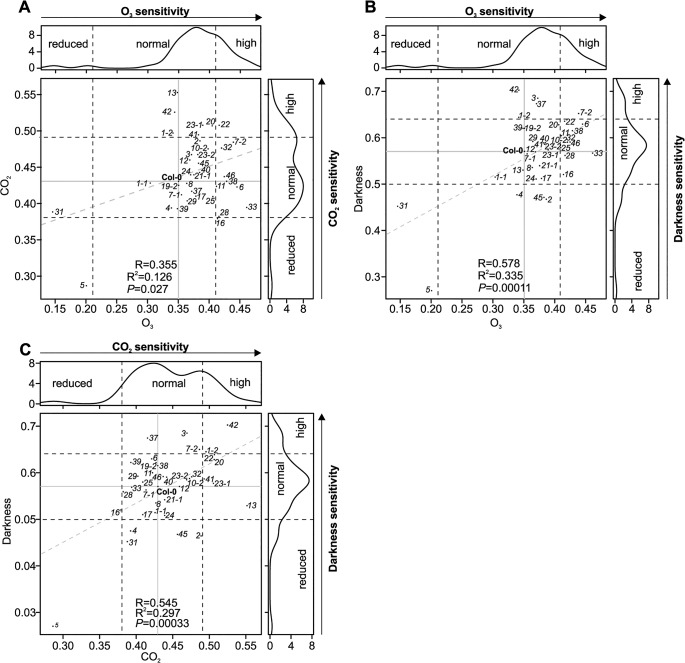
Scatter plots of stomatal regulation in crk mutants.The crk5 was insensitive to all studied stimuli, whereas crk31 was particularly insensitive to O3. The lines crk19-1 and crk22 were more sensitive to the analysed stimuli. (A) Scatter plot of stomatal responses of crk mutants to O3 (x-axis) and CO2 (y-axis). (B) Scatter plot of stomatal responses of crk mutants to O3 (x-axis) and darkness (y-axis) (C) Scatter plot of stomatal responses of crk mutants to CO2 (x-axis) and darkness (y-axis). Dashed lines indicate the cut-off for reduced, normal, and high response with respect to Col-0. Grey dashed lines show regression fit with correlation (R), coefficient of determination (R2) and significance reported in lower right corner in each plot. Reduced or increased responses were statistically significant in the majority of mutants (see respective barplots in S17, S18 and S19 Figs).